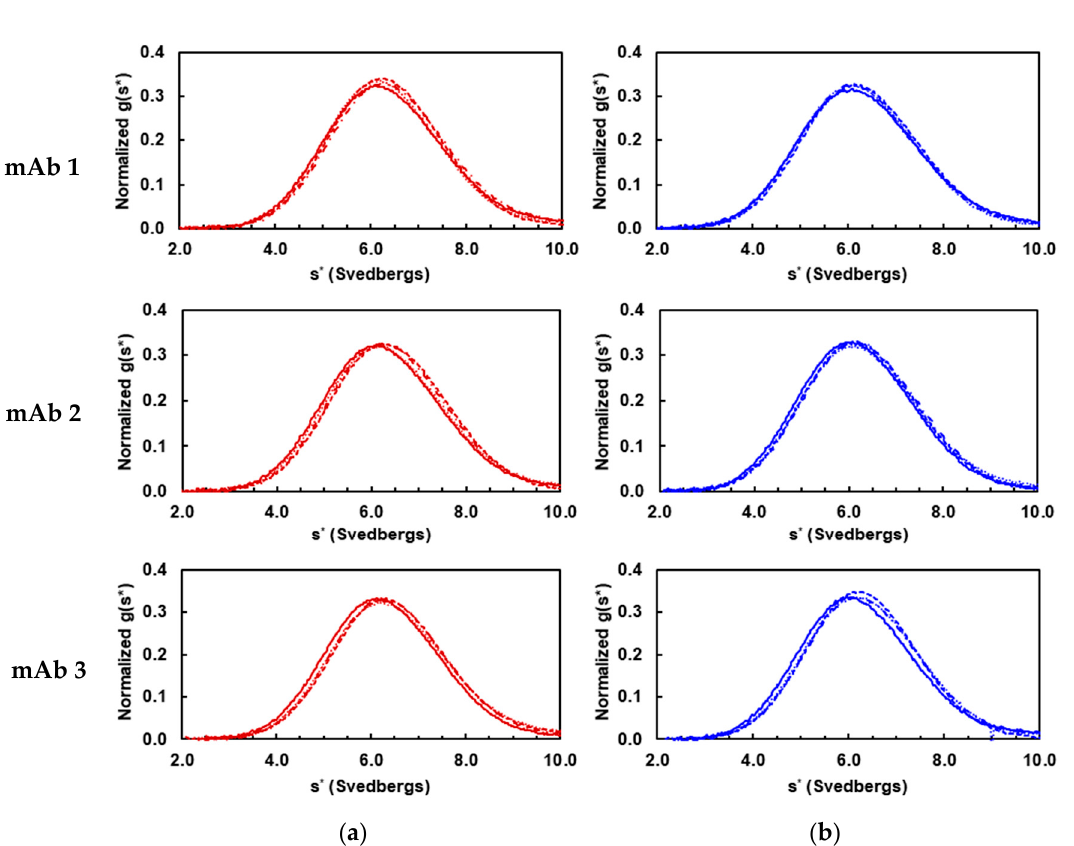
Figure 1. Sedimentation velocity analysis of IgG subclasses from mAb1, mAb2, and mAb3 in ( a ) pH 5.0 acetate (red) and ( b ) pH 7.4 PBS (blue) solutions. Normalized g(s*) sedimentation distributions are obtained from IgG1 (solid line), IgG2 (dotted line), IgG4 (dashed line), and IgG4Pro (dot-dashed line) in both buffers. The curves are superimposed on each other in both panels.